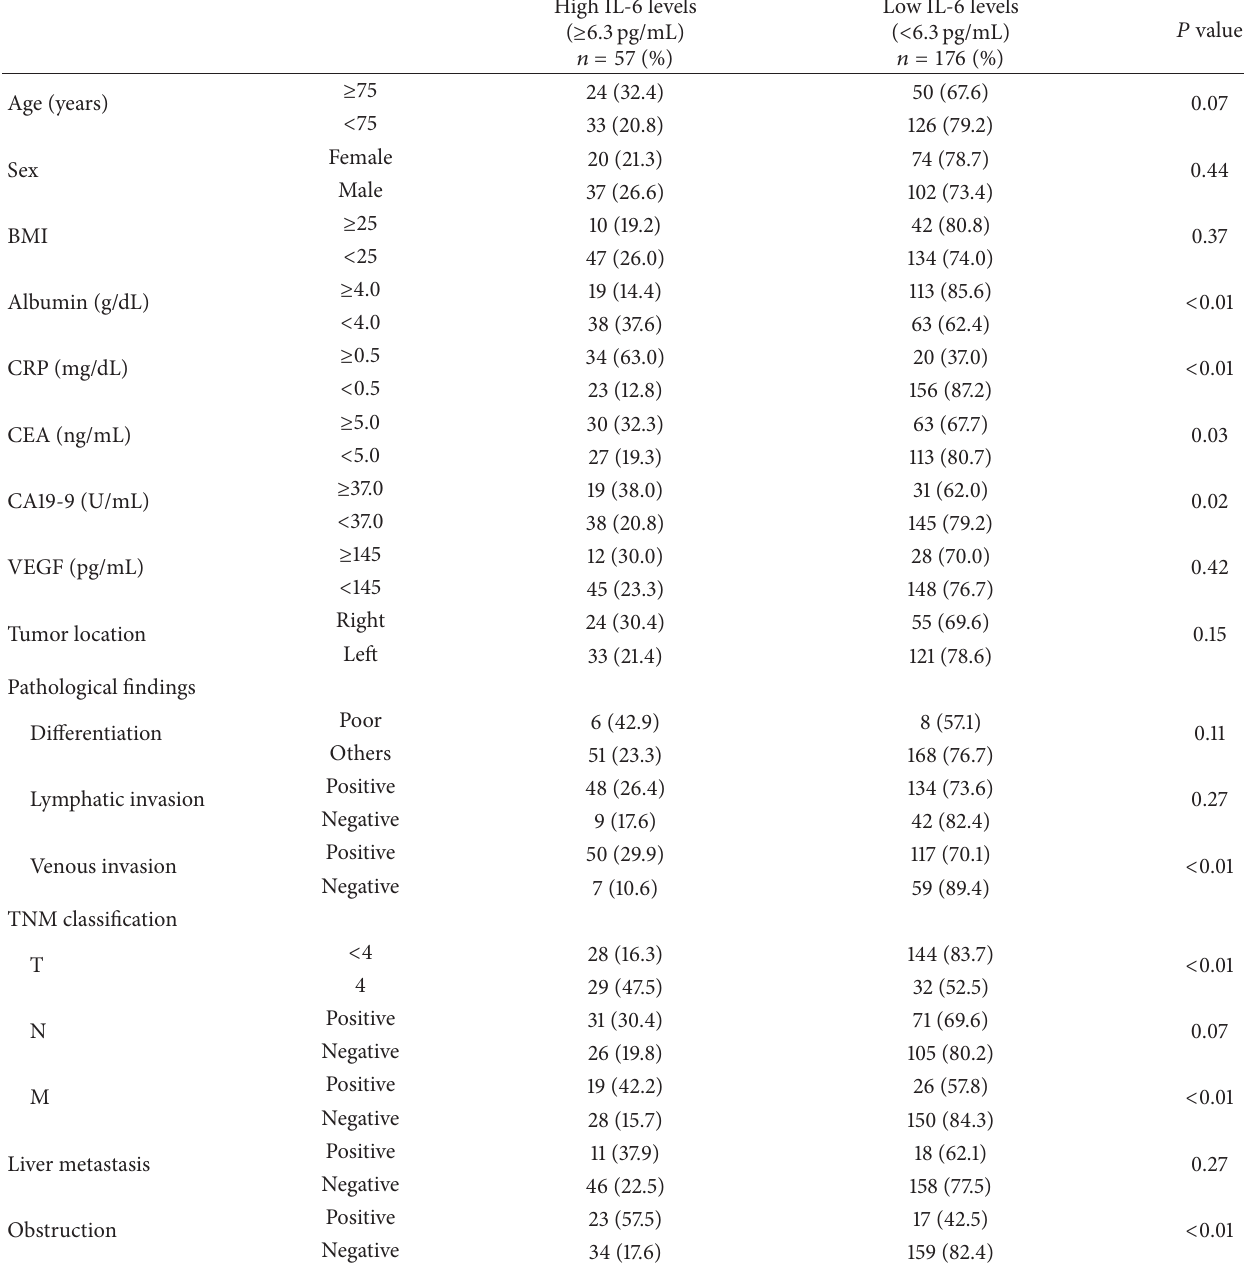
Table 2: Results of the univariate analyses ( 𝑛 = 233